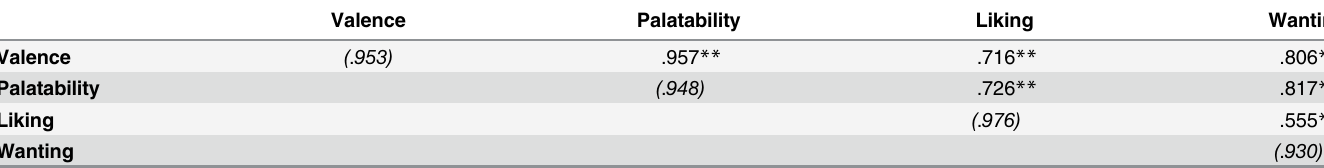
Table 2. Reliabilities and Pearson ’ s product-moment correlations between the self-reported valuation dimensions. Valence Liking